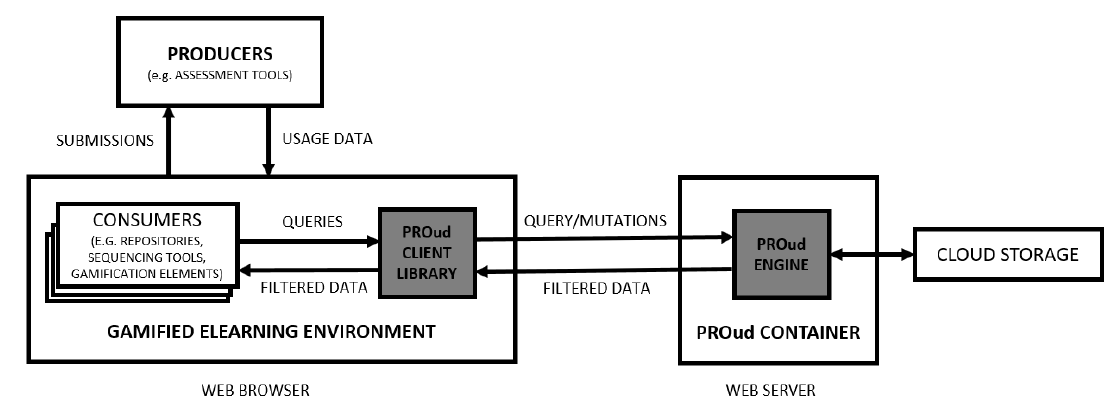
Figure 3. PROud architecture.